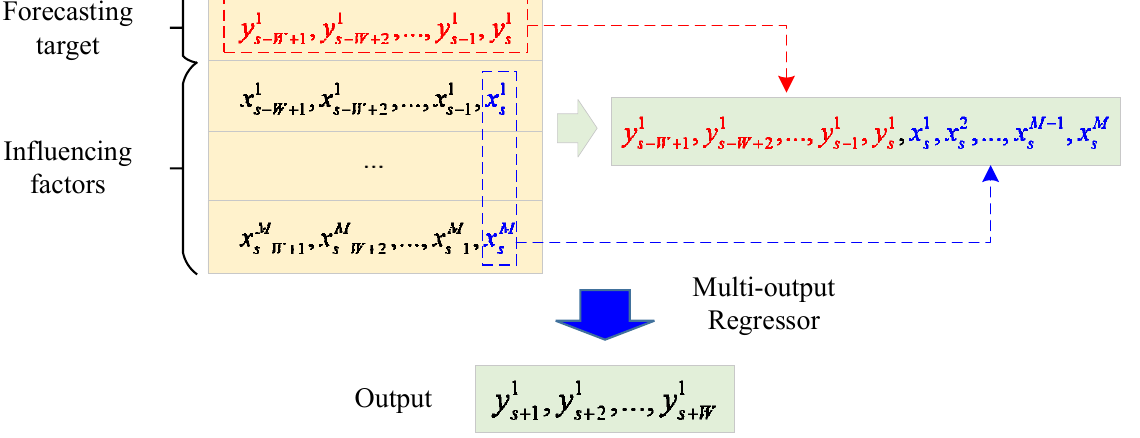
Figure 1. The basic principle of XGBoost(W-b) algorithm.